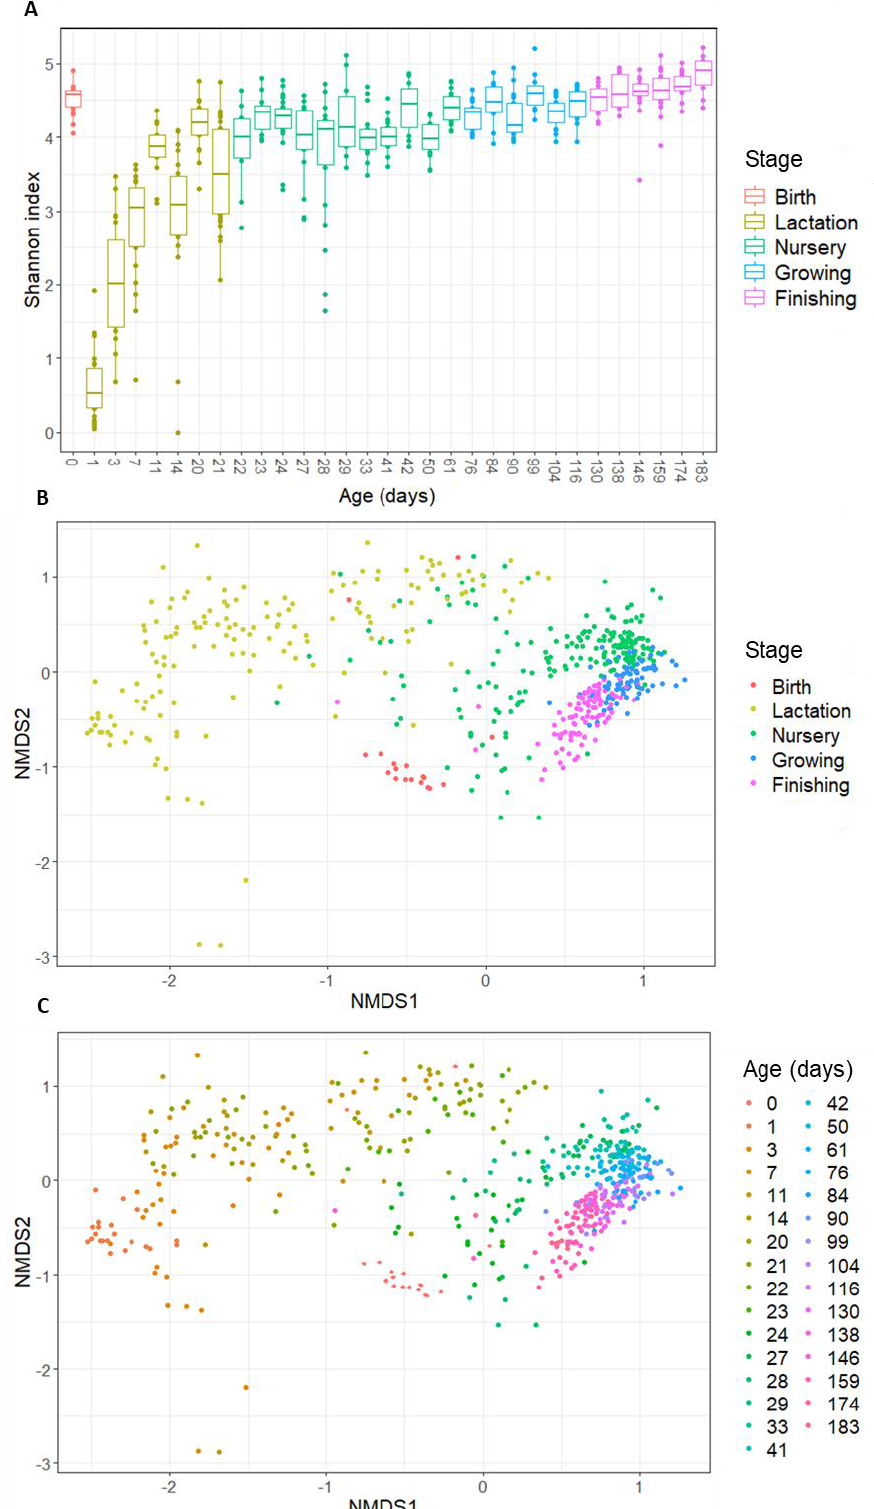
Figure 1. ( A ) Alpha-diversity (Shannon index) of the porcine gut microbiota in function of age, coloured per growth stage; ( B ) beta-diversity (Bray–Curtis distances) of the porcine gut microbiota in function of growth stage; and ( C ) beta-diversity (Bray–Curtis distances) of the porcine gut microbiota in function of age (in days). Samples from day 0 are depicted with a diamond shape while the other ages are depicted using dots in graph C.